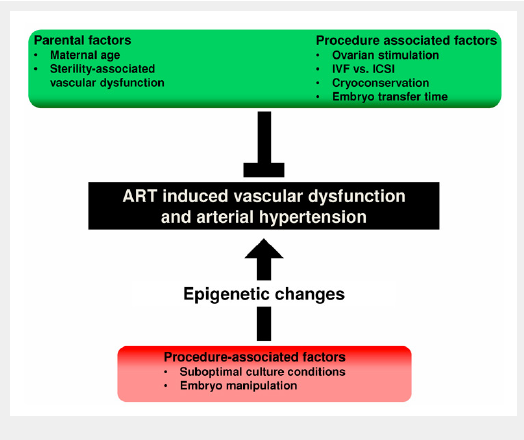
Potential factors involved in the development of ART-induced vascular alterations. Parental and procedure-associated factors that seem not to be major determinants of vascular changes are marked in green, procedure-associated factors that may play a major role in